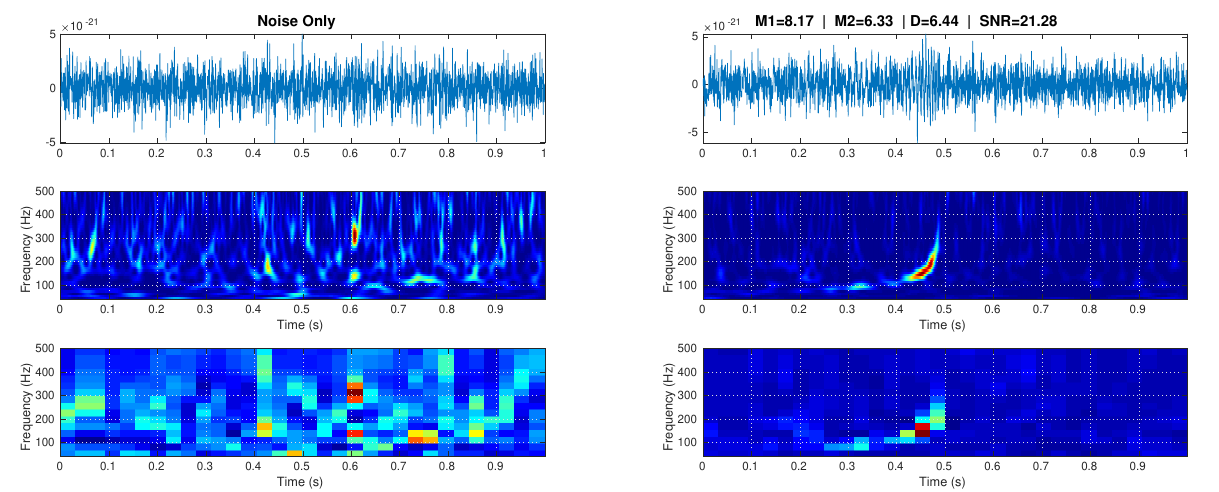
Figure 4. Visualization of two image samples of T win = 1.0 s, generated from a strain data segment of length 4096 s and GPS initial time 932335616, recorded at the L1 detector. In the left panel, a sample of noise alone (class 1) is shown, and in the right panel a sample of noise plus GW (class 2). In the class 2 sample, masses M 1 and M 2 are in solar masses units, distance D in Mpc, and SNR is the expected signal-to-noise ratio. Upper panel show strain data in the time domain, middle panels show time-frequency representations after apply a WT, and bottom panels show resized images by a bicubic